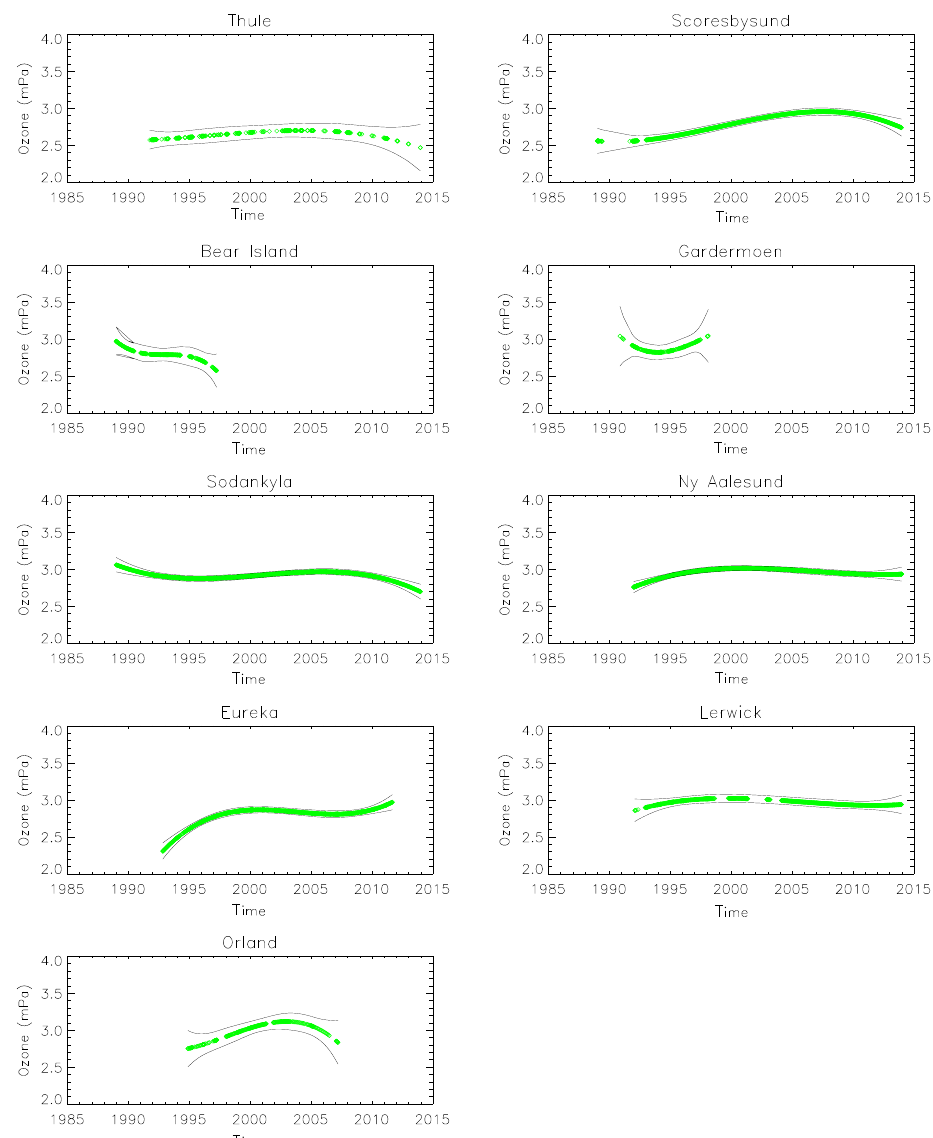
Figure 5. The polynomial part of the model as a function of time at 500hPa. Green curve shows posterior mean, black curves indicate the 95% confidence intervals for each point in time. Model settings: n pol = 4, n cyc = 2, n a tr = n θ tr = 0 and white